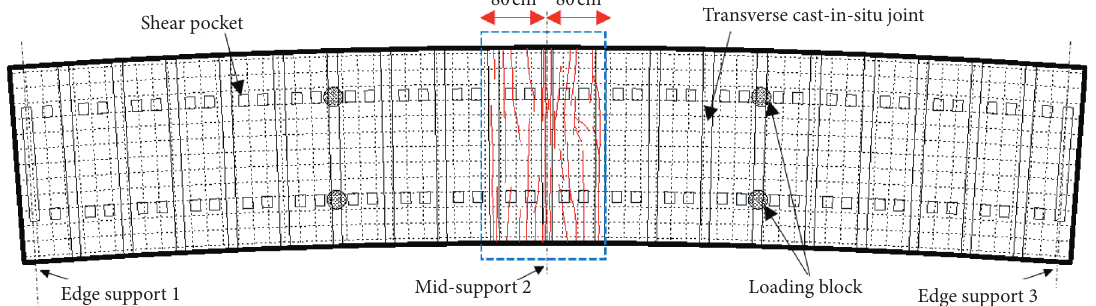
Edge support 1 Figure 9: Concrete slab cracking distribution at the end of the